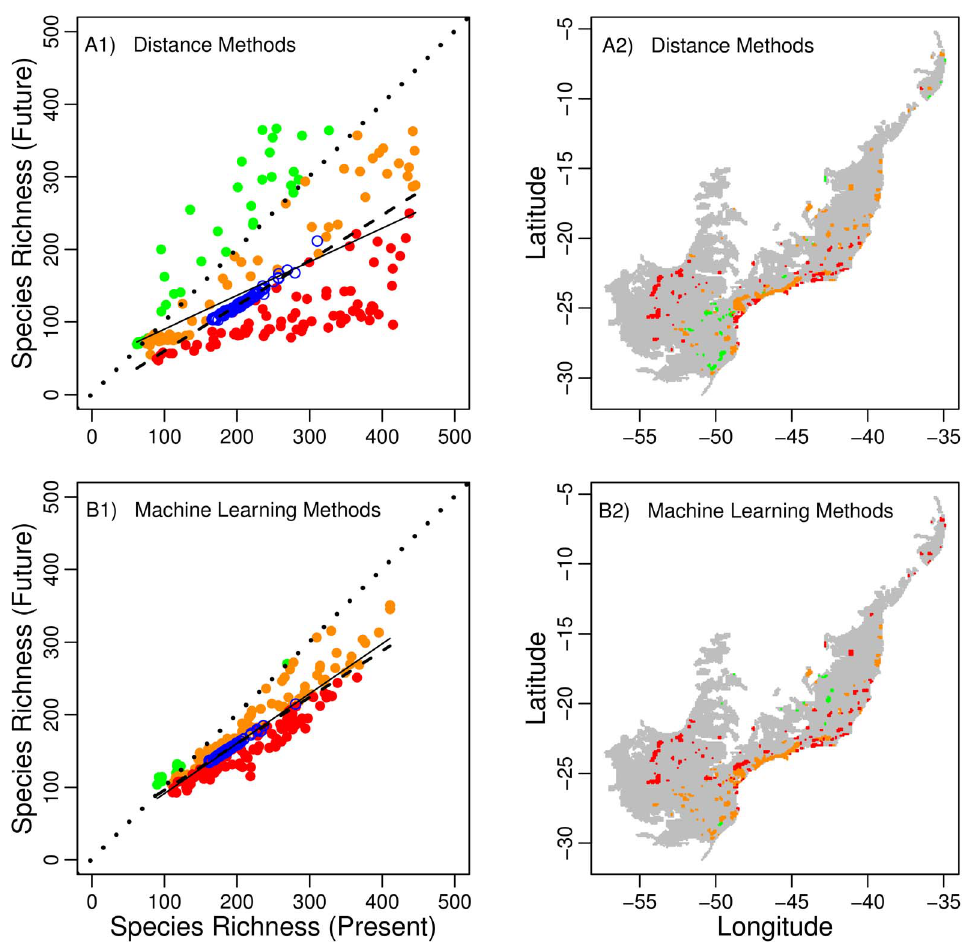
Figure 6. Relationship between present and future tiger moth species richness in the Atlantic Forest Biodiversity Hotspot, Brazil. Modeled present and future species richness of protected areas (filled circles) in the Atlantic Forest biome (A1 and B1). Open blue circles indicate expected species richness according to a null model of random location of protected areas in the biome. Dashed lines are the extrapolated regressions of the expected species richness according to the null model (A1: y , 2 1.983 + 0.623*x; B1: y , 32.178 + 0.640*x). Filled red circles indicate protected areas predicted to have severe species richness losses, defined as those in which future species richness will be lower than the predicted by a null model of random location of protected areas (below dashed regression line). Orange filled circles indicate protected areas predicted to have mild species richness losses, defined as those in which future species richness will be higher than the predicted by a null model of random location of protected areas. Green filled circles indicate protected areas predicted to gain species richness. Solid lines indicates the regression of modeled species richness in the future against modeled species richness in the present (A1: y , 43.817 + 0.464*x, R 2 =0.362, F 1,185 =105.2, P , 0.001; B1: y , 22.736 + 0.688*x, R 2 =0.850, F 1,185 =1051.0, P , 0.001). Maps of protected areas predicted to gain (green) or lose (orange, red) species in future changing climate (A2 and B2).